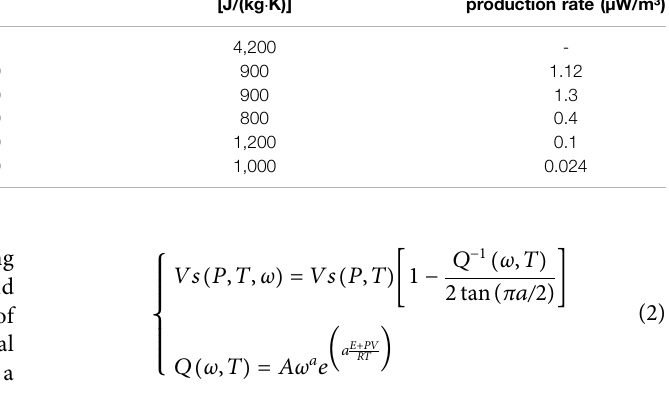
TABLE 1 | Thermophysical property parameters (Zhang et al., 2005; Meng and Zhang, 2014).